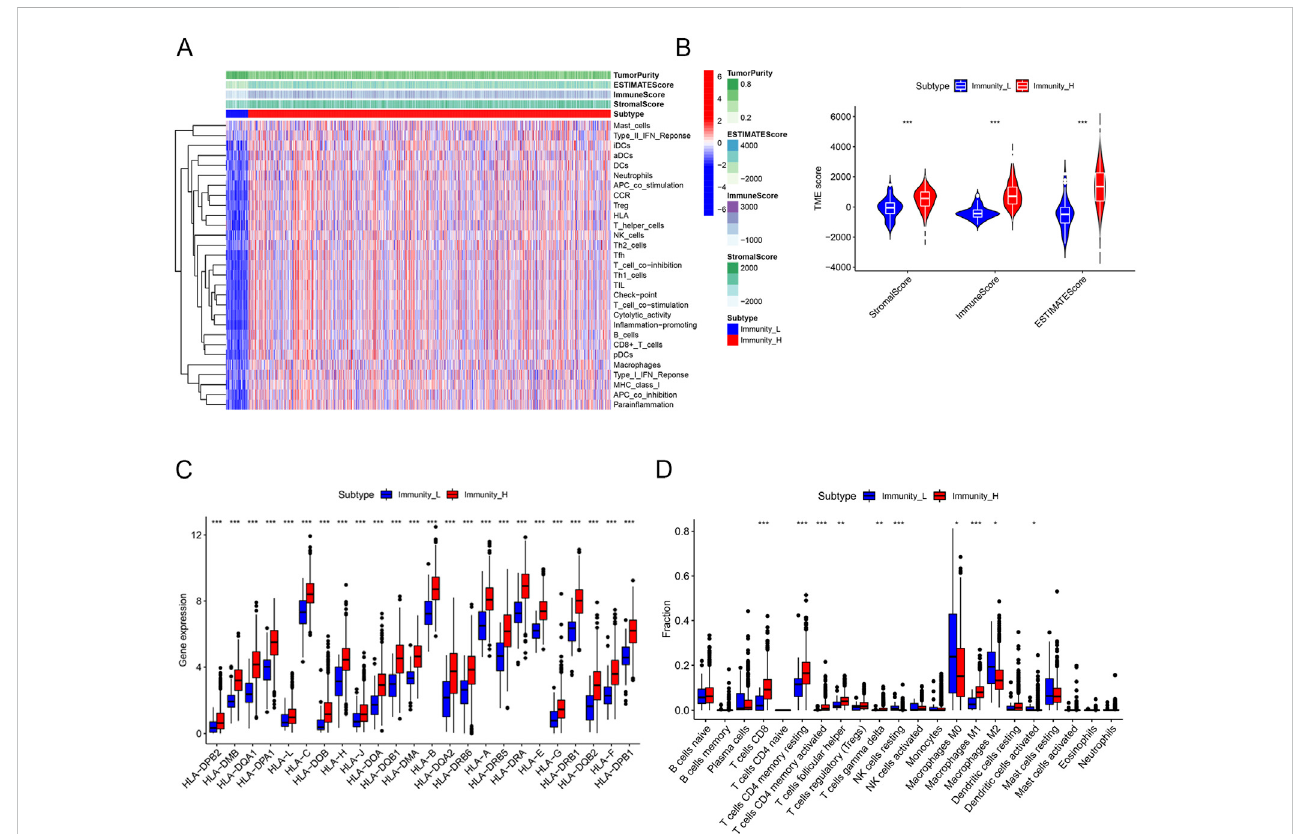
FIGURE 2 Construction and validation of immune clustering. (A) Heatmap showing enrichment levels of 29 immune cell types between the two clusters. The ImmuneScore,StromalScore,ESTIMATE Score,andtumorpuritycanbeseenontopofthegenes. (B) Violin plotsshowingtheStromalScore,ImmuneScore, andESTIMATEScoreofthetwoclusters. (C) BoxplotsshowingthegeneexpressionoftheHLAfamilyofthetwoclusters. (D) Boxplots showingproportionsof 22 immunecell types between the two clusters. Proportions of CD8 T cells, resting memory CD4 T cells, CD4 memory activated Tcells, follicular helper T cells, gamma delta T cells, and M1 macrophages were higher in the cluster with high immune cell in fi ltration, whereas the proportions of resting NK cells, M0 macrophages, M2 macrophages, and activated dendritic cells were lower in the cluster with high immune cell in fi